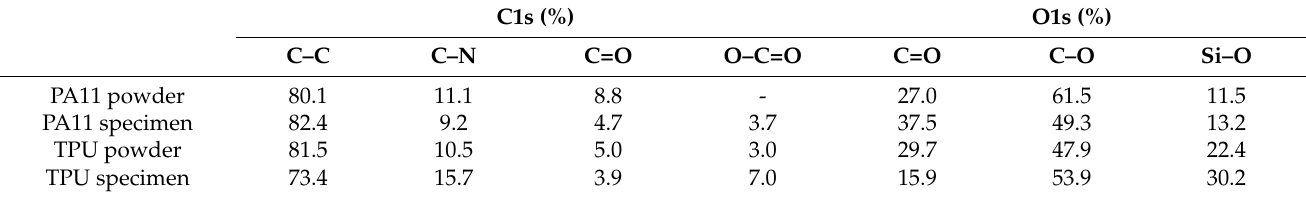
Table 3. Chemical composition of chemical bonds for both powders and